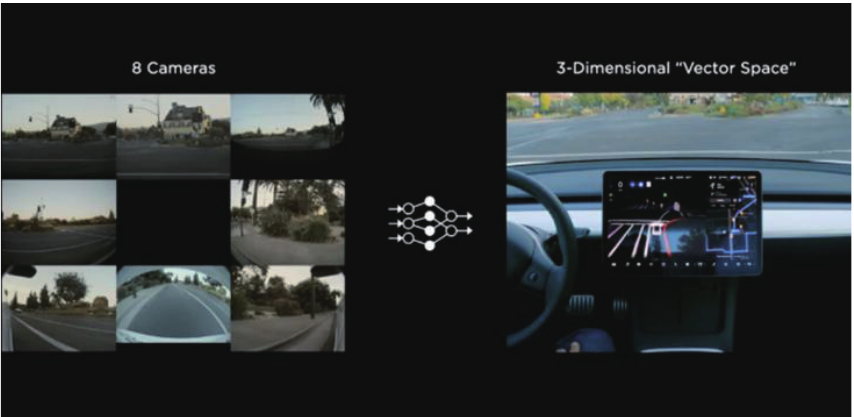
Figure 4. Live view of a Tesla self-driving car. The webpage referenced in this figure is